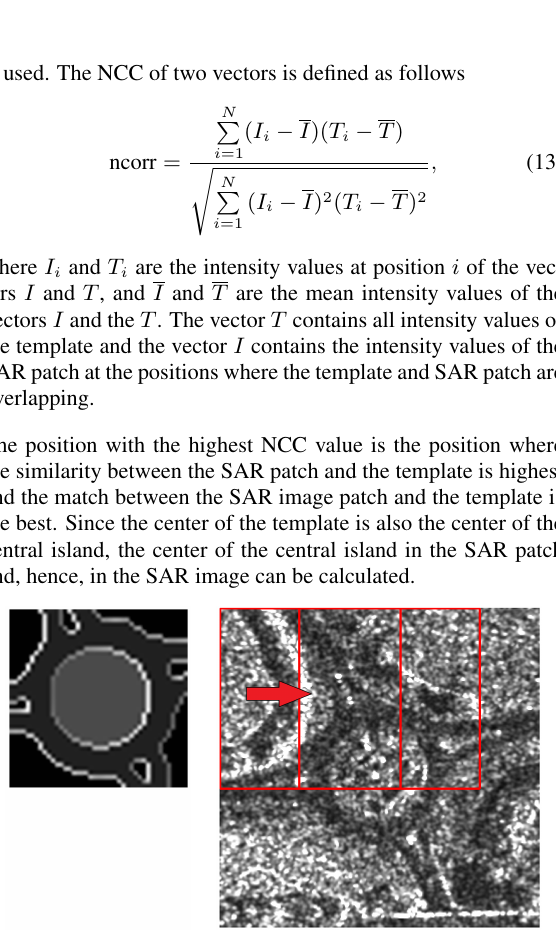
Figure 4. Illustration of the SAR image and template matching. The roundabout template (left) and the SAR image patch (right). The black areas around the template are no part of the template. The red marked areas in the SAR patch are two positions where the NCC is calculated.